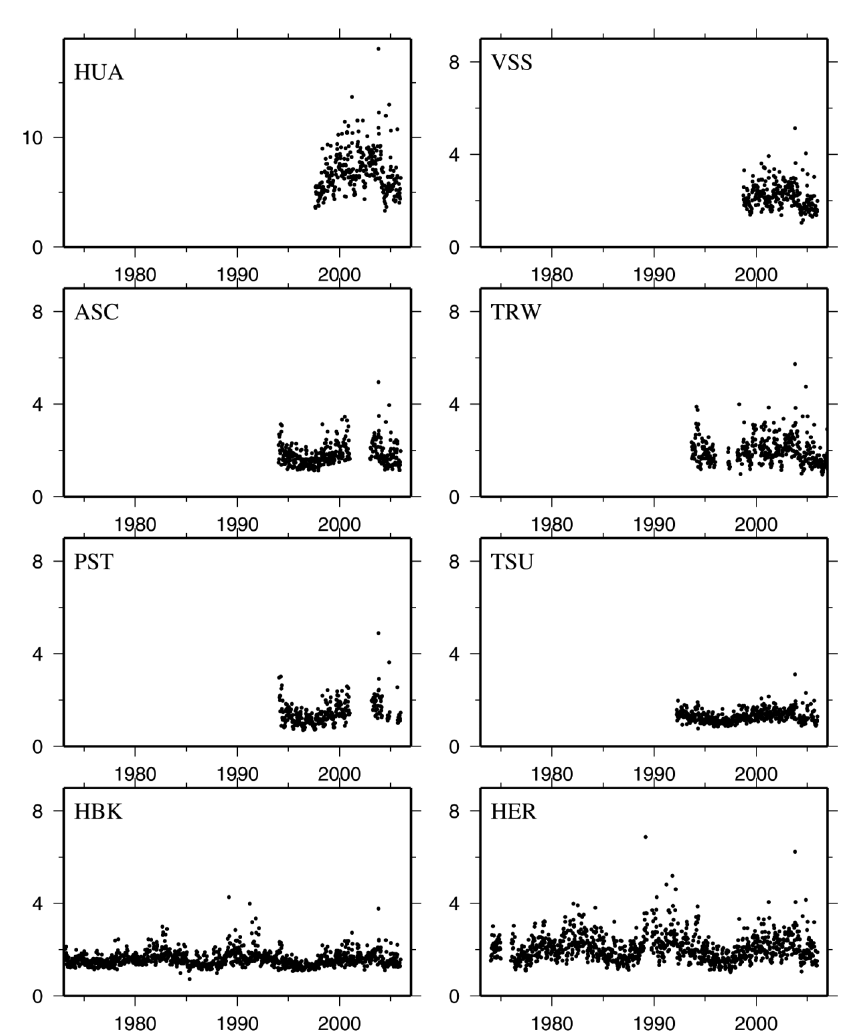
Fig. 6. Ten-day means of hourly standard deviations of total intensity ( µ T). Note different scale used for HUA which is close to dip equator and therefore affected by the equatorial electrojet. Observatories organised by |in- clination| from left to right, top to